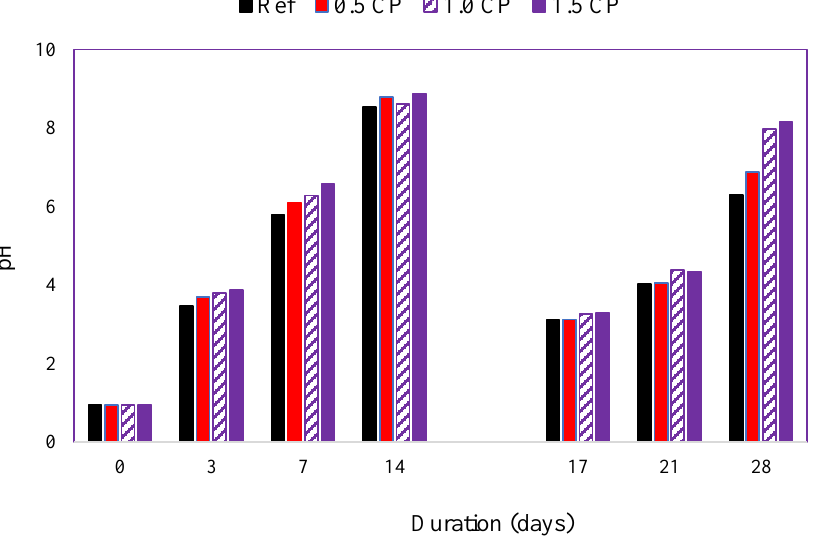
Figure 8. pH evolution of the 0.5 M HCl solution.